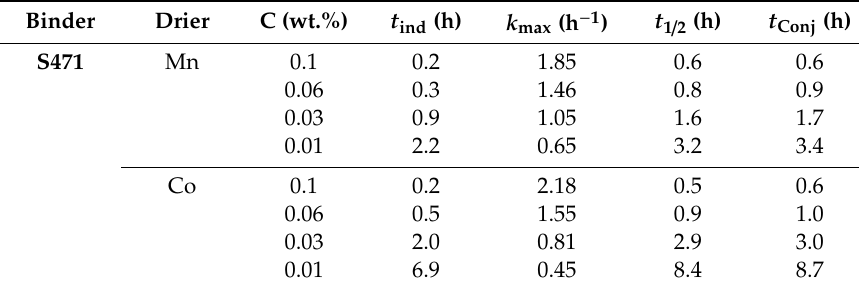
Table 6. Kinetic parameters for Mn / S471 and Co / S471 .